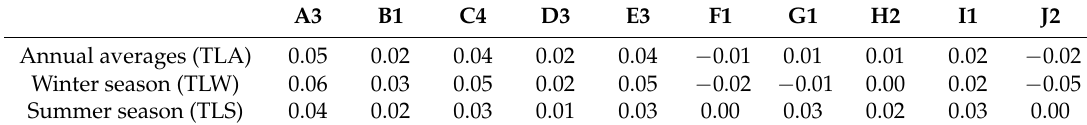
Figure 7. Distribution of the Hs wave conditions in the sites considered, for the ECMWF ERA-Interim dataset, corresponding to the time interval 1983 – 2017. The data were processed in terms of maximum values, 95 th percentile, and average values in comparison to the upper three wind classes (C6 – C8) of the Douglas Table 4. Linear trend (m per decade) values of the average significant wave height, computed for 10 reference points (one of each zone) considered as the most representative. Results corresponding to the 35-year time interval 1983–2017.